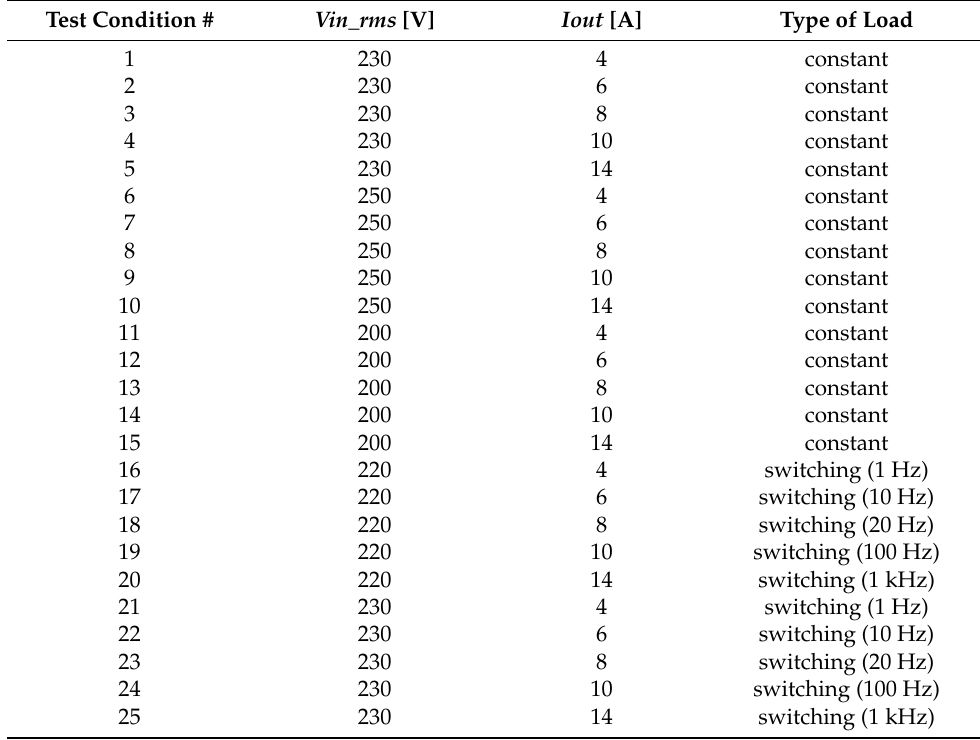
Table 2. Experimental test conditions for achieving the nominal model of the AC/DC converter.